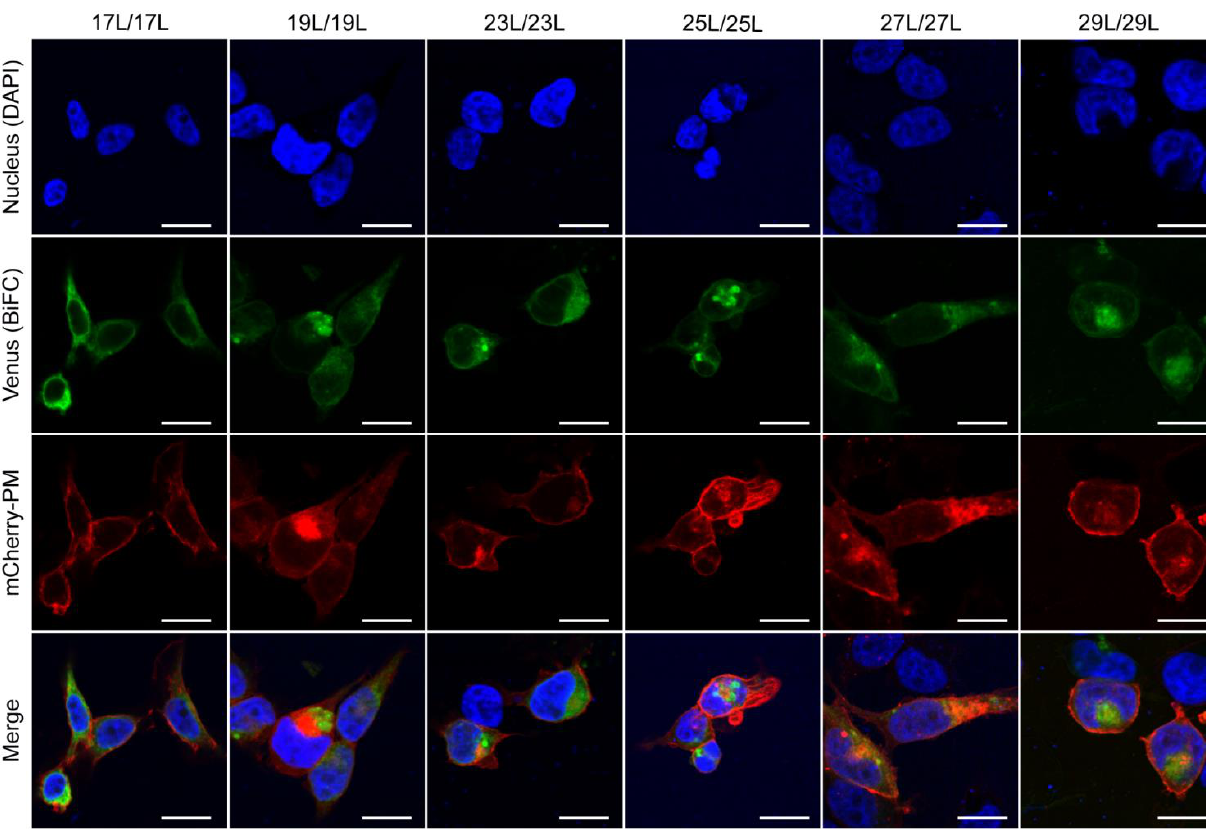
FIGURE 11: Homo-dimerization at the plasma membrane. Confocal microscopy of DAPI stained (blue) HEK293T cells expressing chimeras (17L [VN- 17L/VC-17L], 19L [VN-19L/VC-19L], 23L [VN-23L/VC-23L], 25L [VN-25L/VC-25L], 27L [VN-27L/VC-27L], 29L [VN-29L/VC-29L]). TM-driven homo- oligomerization results in VFP reconstitution and fluorescent signal (green). Neuromodulin fused to mCherry fluorescent protein was used as plasma membrane marker (red). The presence of colocalization of red and green signals in the merge images was highlighted in yellow. Scale bar size was set to 16